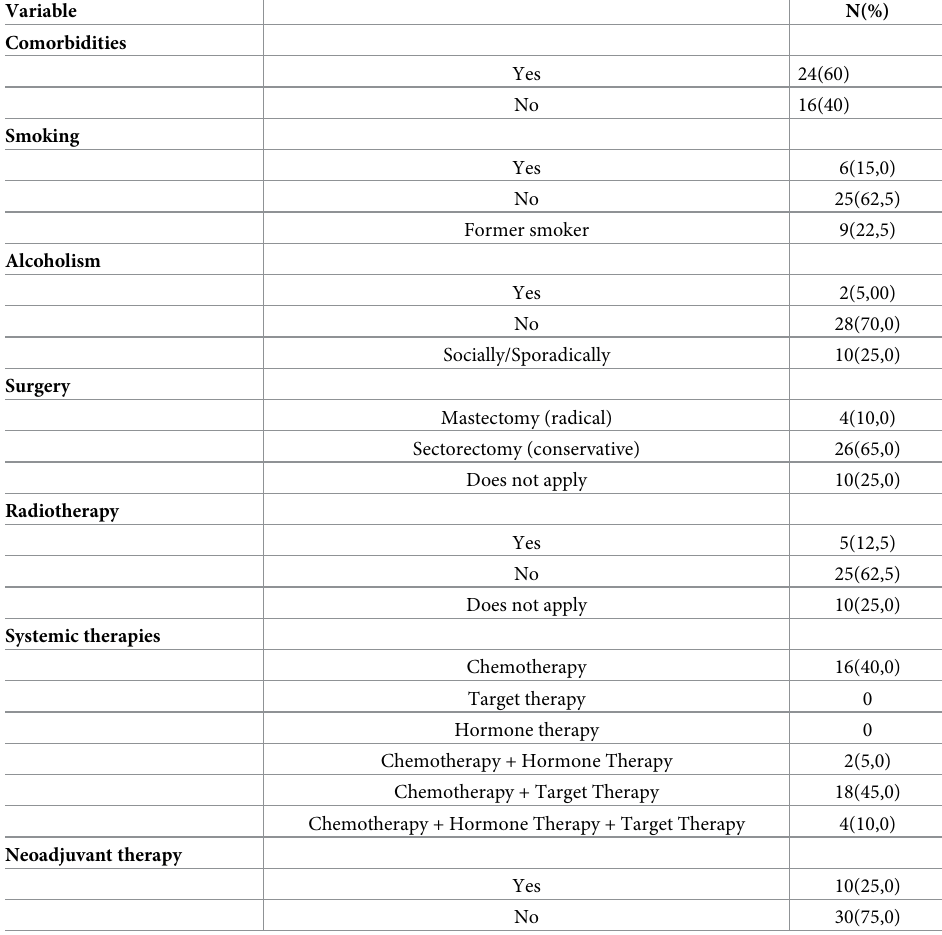
Table 2. Clinical